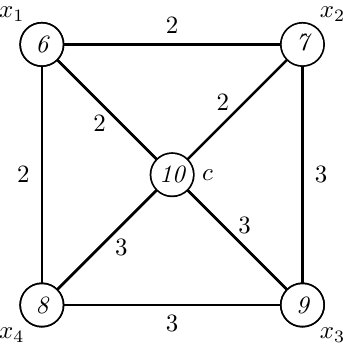
Figure 2. An irregular 3-labeling of the wheel W 4